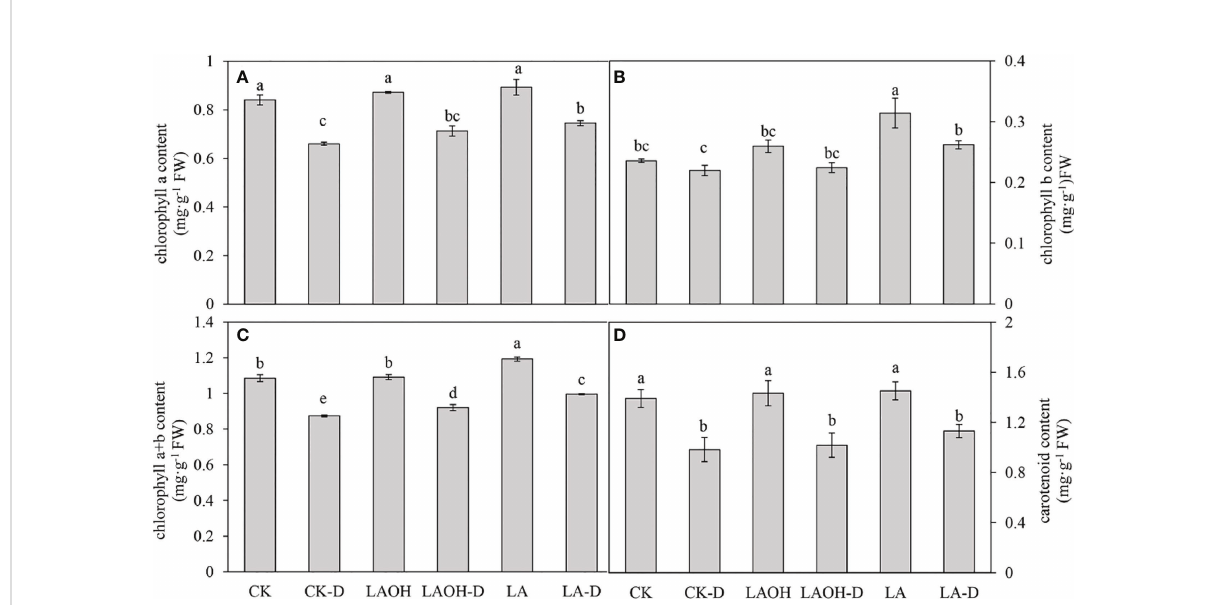
FIGURE 5 Effects of LA-OH and LA on photosynthetic pigment content in P. persica leaves under drought stress (A) chlorophyll a content; (B) chlorophyll b content; (C) chlorophyll a+b content; (D) carotenoid content). Data are mean ± SD (n = 3). Duncan ’ s test and ANOVA were used. Signi fi cant differences (P < 0.05) are indicated by different letters.